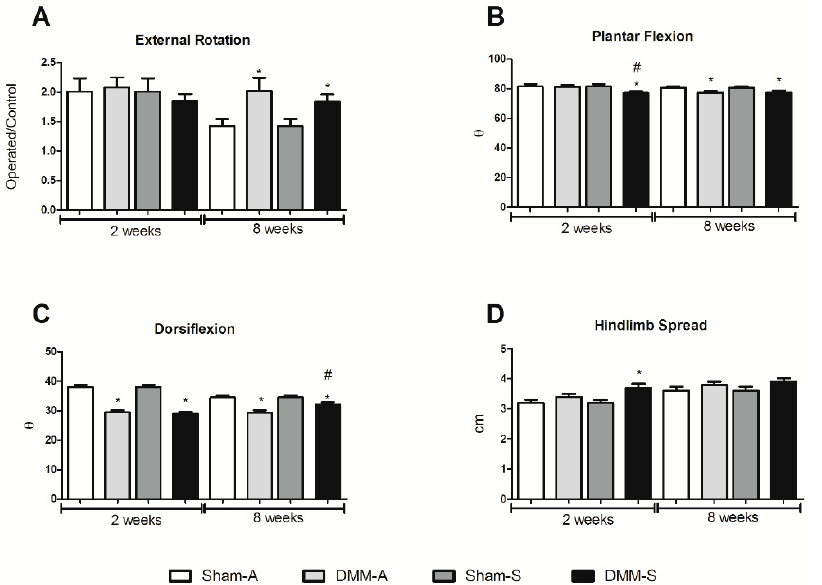
Figure 1. Animal gait demonstrated minimal differences between RNU (Sham-A and DMM-A) and Sprague Dawley (Sham-S and DMM-S) animals. Gait measurements demonstrated minimal changes in external foot rotation ( A ), a minor decrease in plantar flexion after 2 weeks ( B ), increased dorsi flexion after 8 weeks ( C ), and no change in hindlimb spread after 8 weeks ( D ). * Indicates a difference from sham control ( p < 0.05, t -test) and # indicates a difference from RNU ( p < 0.05, t -test). Data shown are means ± SEM of 8 animals.